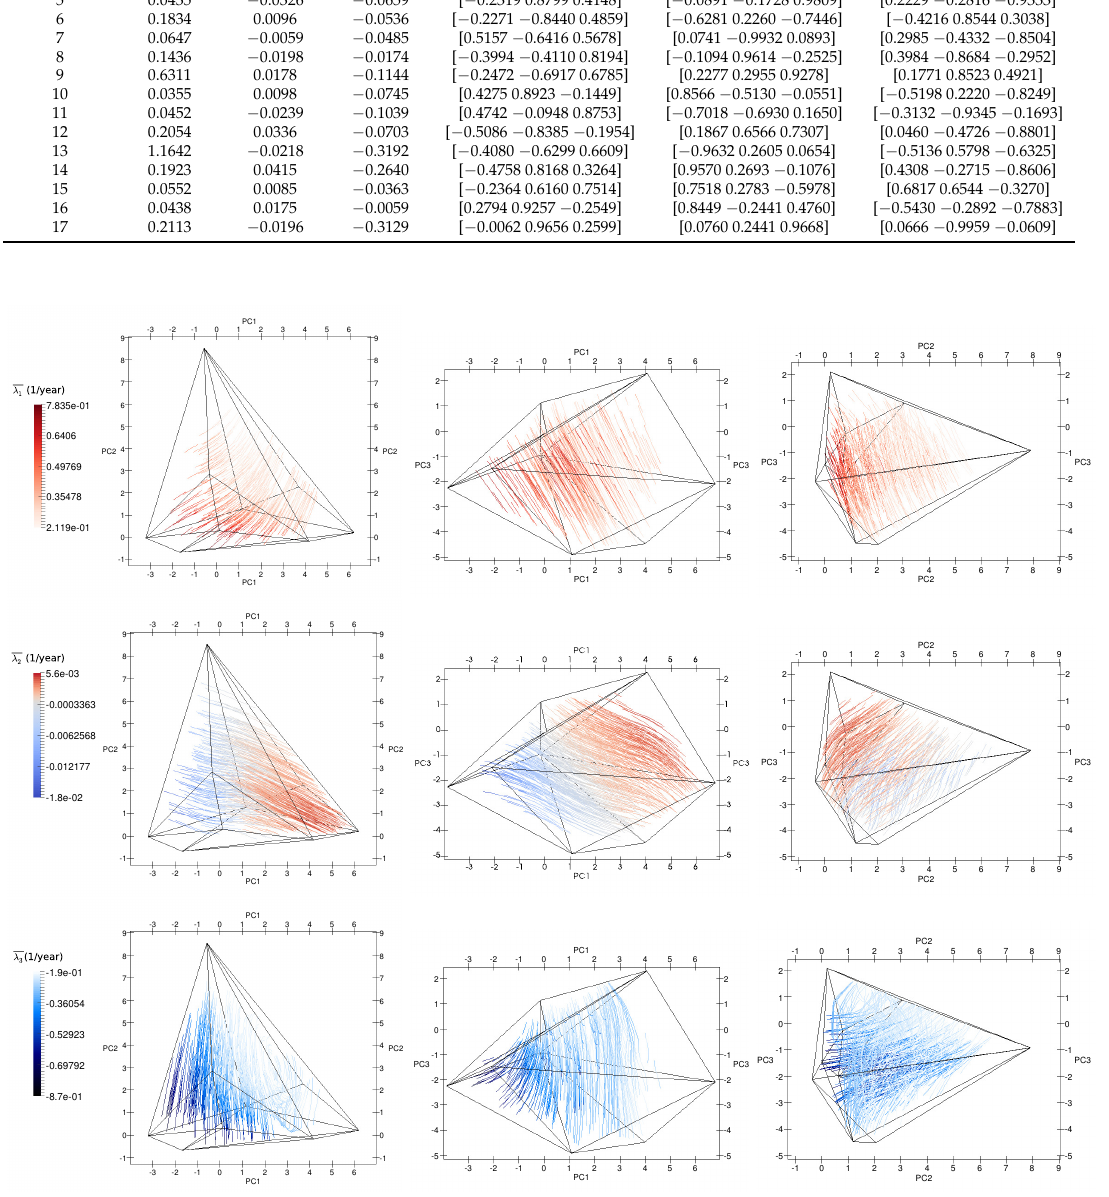
Figure 6. The trajectory patterns of the time-averaged principal strain-rates: averaged first principal strain-rate ( top ); averaged second principal strain-rate ( middle ); and averaged third principal strain-rate ( bottom ). In these graphs, the red color is used to represent extension, while the blue color depicts